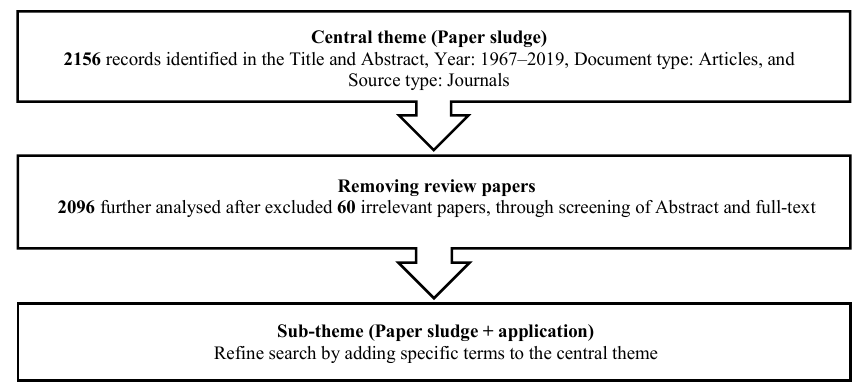
Fig. 1. Scheme of central and sub-themes data mining of